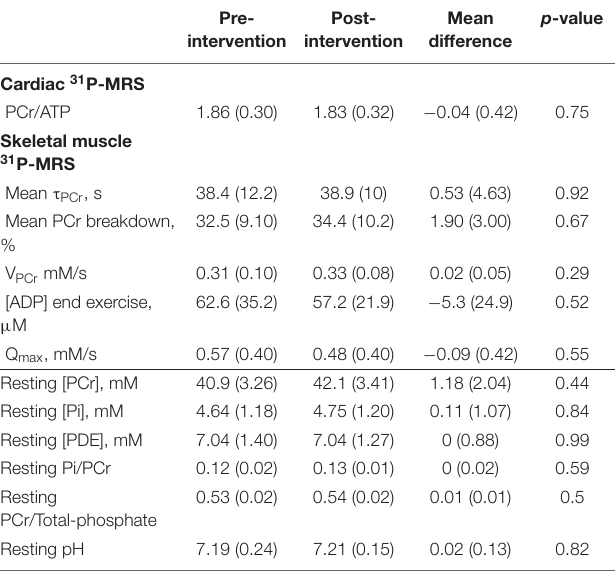
TABLE 2 | Cardiac and skeletal muscle 31 P-MRS parameters, pre- and post-intervention.